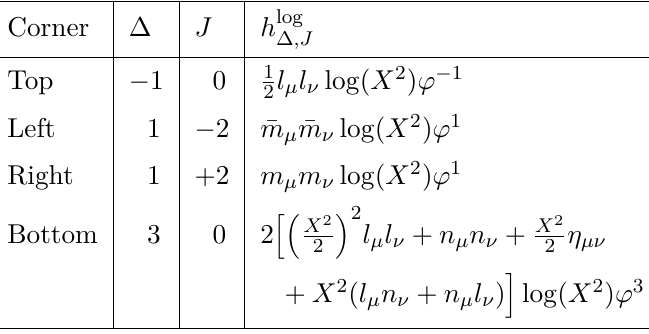
Table 17. Elements of the celestial diamond corresponding to gravitational